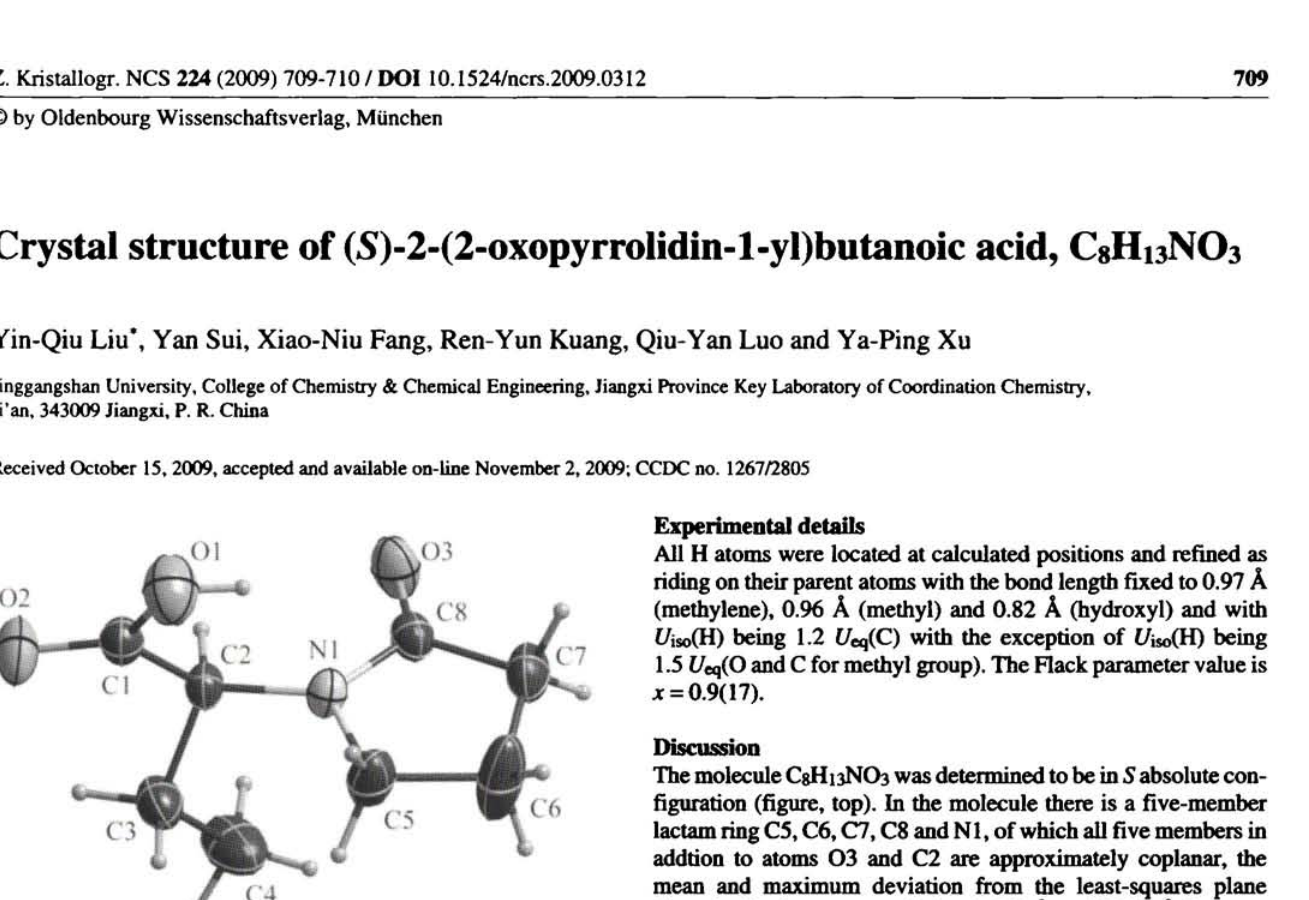
Table 1. Data collection and handling.